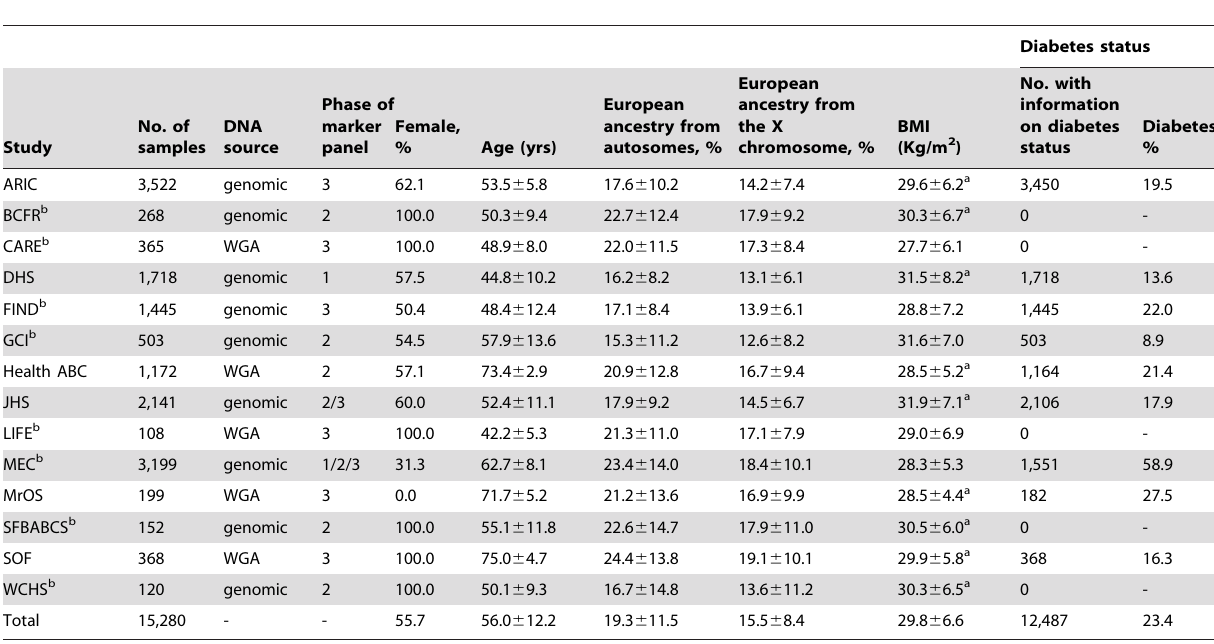
Table 1. Characteristics of 15,280 African American adults by study